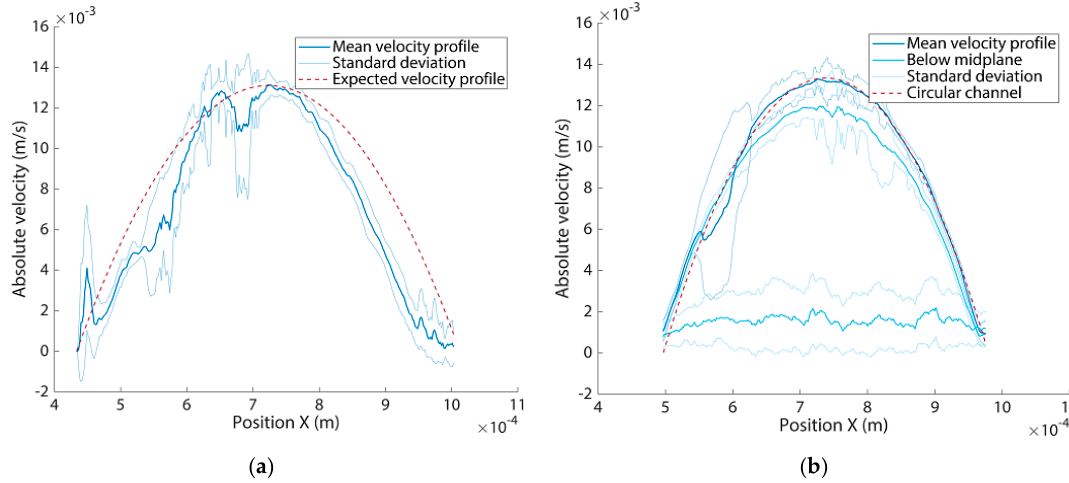
Figure 6. Averaged absolute velocity profile of the inlet channel of a bifurcating network for a circular and square cross-sectional channel in the mid-plane as well as below the midplane, at quarter height and near the bottom wall, for the square channel. ( a ) Averaged absolute velocity of the inlet channel of Figure 5b with standard deviation and the expected velocity profile based on Equation (3). Parameters used for Equation (3) are: Q = 100 µ L / min and a channel radius, r c , of 284 µ m. Area under the curve for the expected velocity profile is 5.05 × 10 − 6 m 2 / s and for the measured velocity profile 4.77 × 10 − 6 m 2 / s; ( b ) Averaged absolute velocity profile with standard deviation of the square cross-sectional channel (500 × 500 µ m) both in the mid plane and below the midplane, at quarter height and near the bottom wall in the channel. The expected velocity profile for a circular channel with equal cross-sectional area is based on Equation (3). Parameters used for Equation (3) are: Q = 100 µ L / min and a channel radius, r c , of 282 µ m.